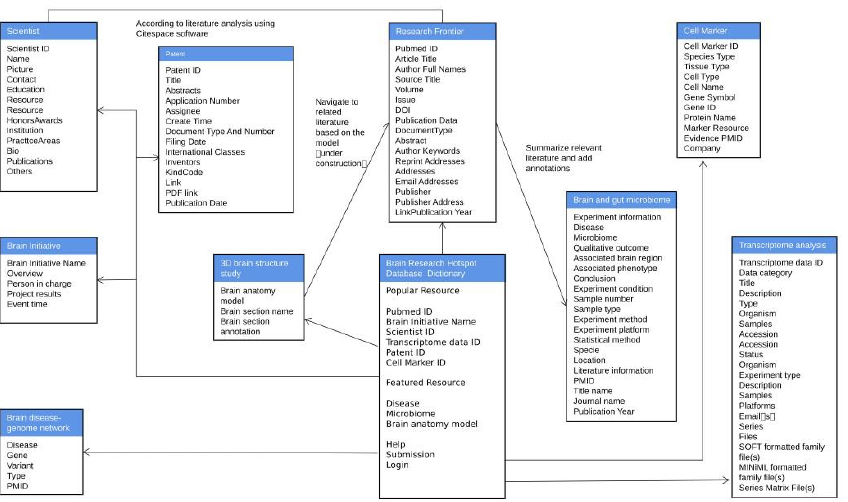
Figure 8. Structure of the relational database. The tables and relationships of the main datasets in the relational database of the BRHD.